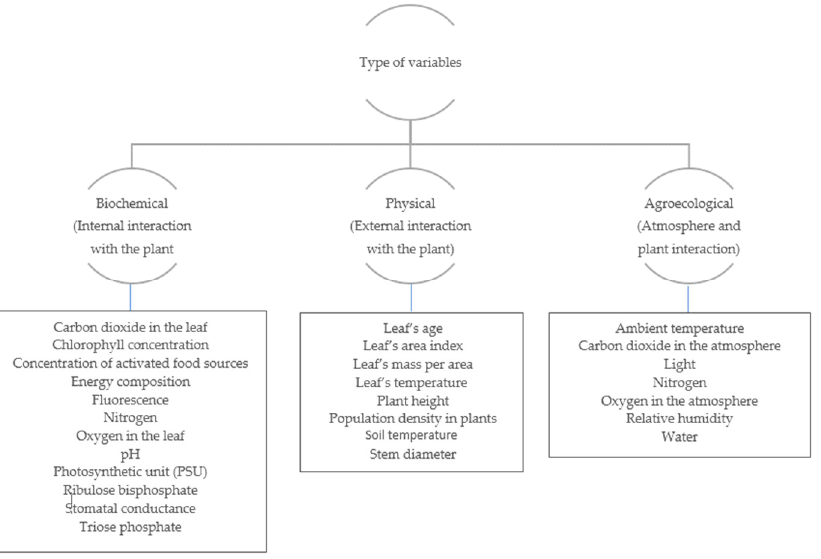
Figure 4. Input variables used in the reviewed mathematical models, classified by biochemical, physical, and agroecological type.